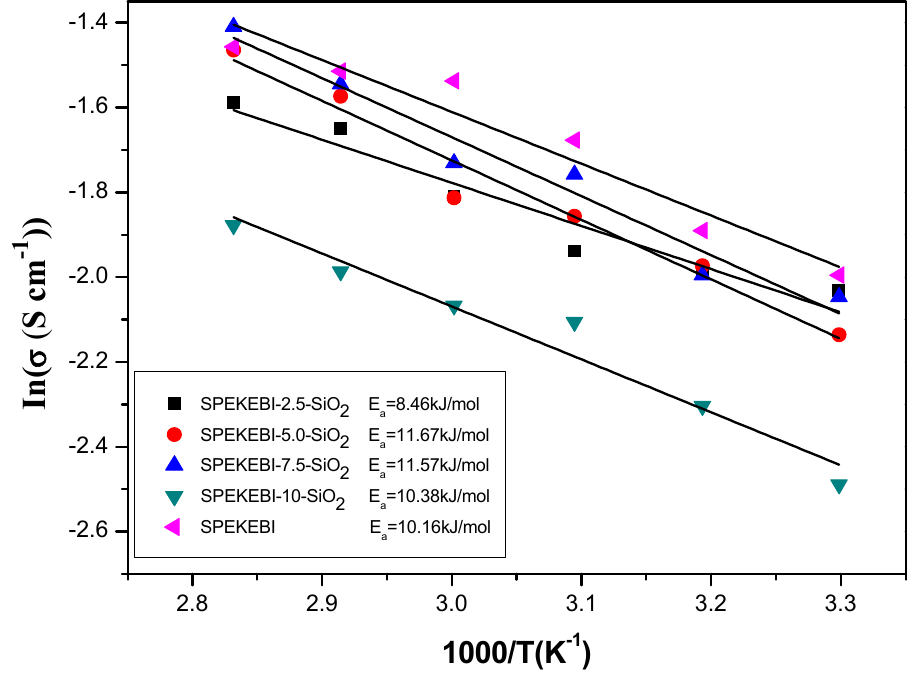
Figure 9. Arrhenius plot of proton conductivity for SPEKEBI-x-SiO 2 and SPEKEBI membranes.